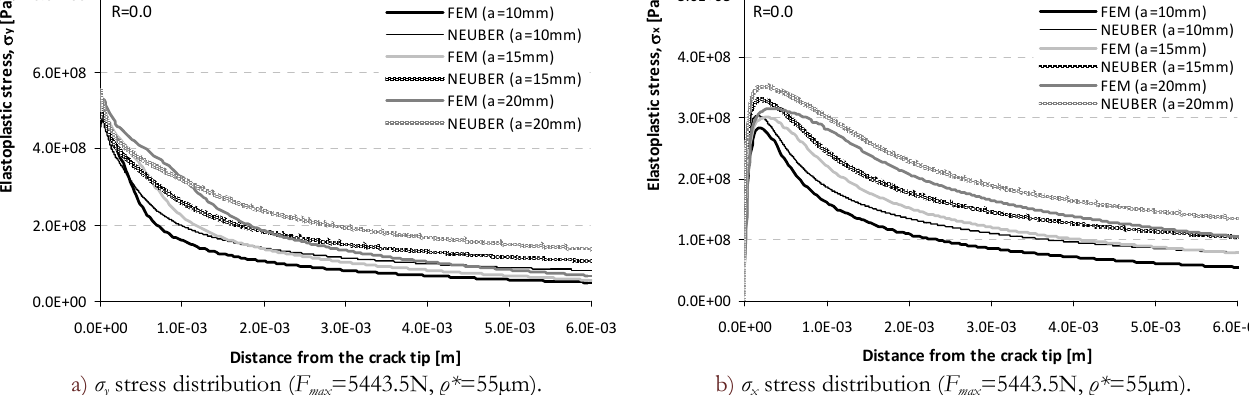
Figure 12: Elastoplastic stress distribution ahead of the crack tip along the crack plane line (y=0) for CT specimens made of S355 steel: comparison between analytical and numerical results. Distinct crack sizes